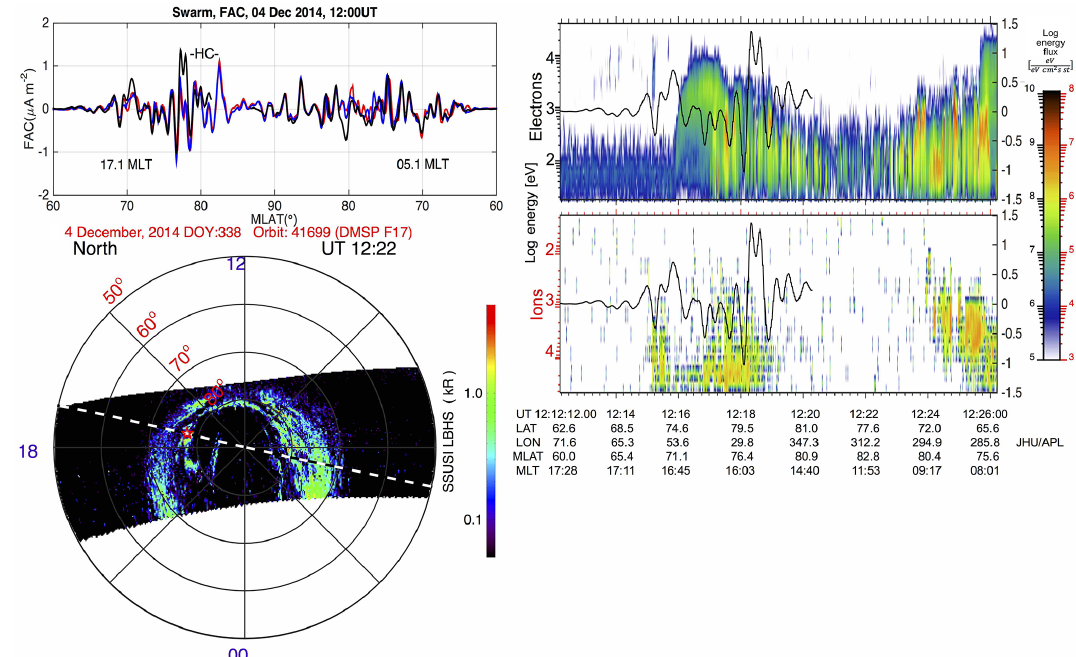
Figure 10. Same format as Fig. 8 but for 4 December